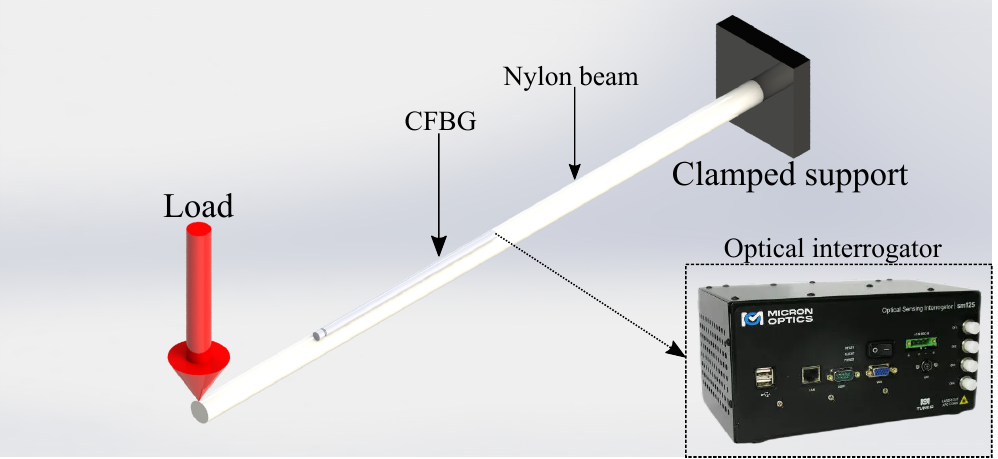
Figure 3. Schematic representation of the static test setup.